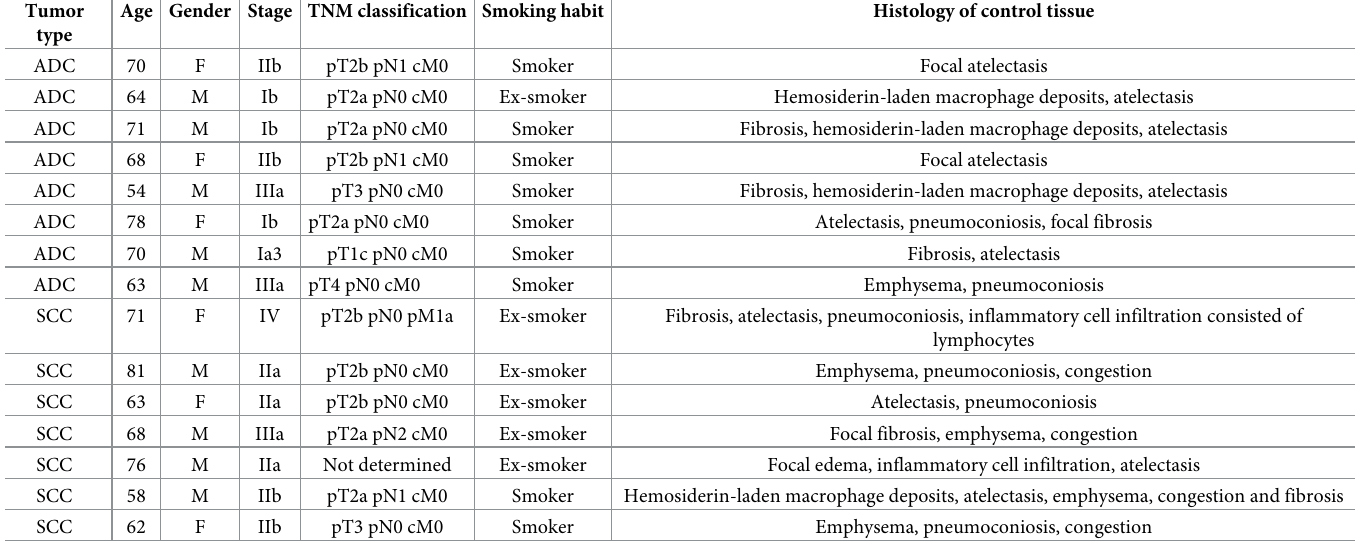
Table 7. Clinical and pathological characteristics of ADC and SCC patients whose samples were included in this study. Tumor Age Gender Stage TNM classification Smoking type